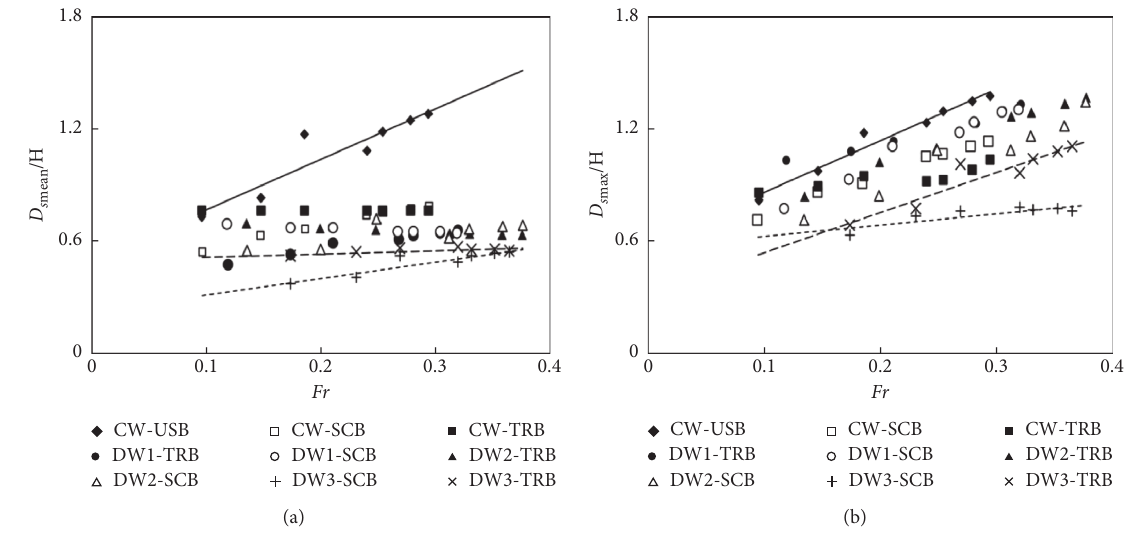
Figure 13: The changes in the dimensionless ratio with the Froude number: (a) mean depth of the scour hole; (b) maximum depth of the scour